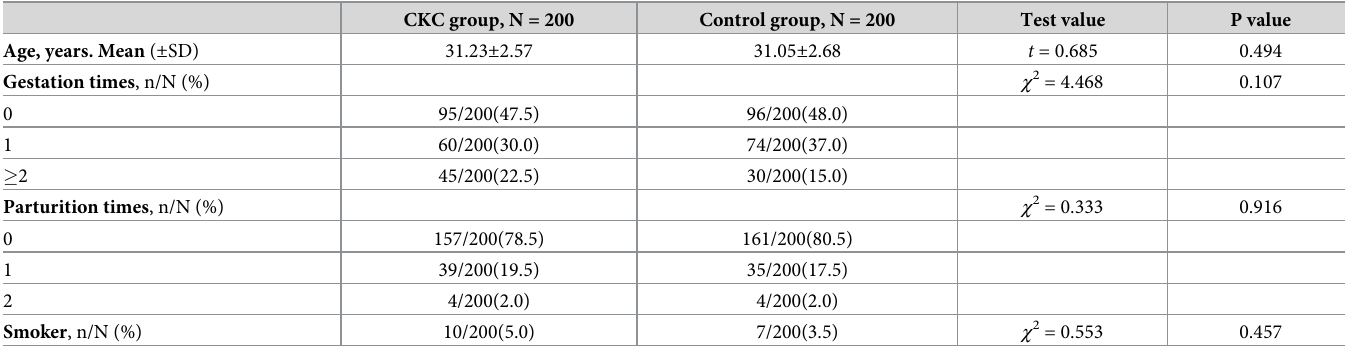
Table 1. Comparison of general data between CKC group and control group.